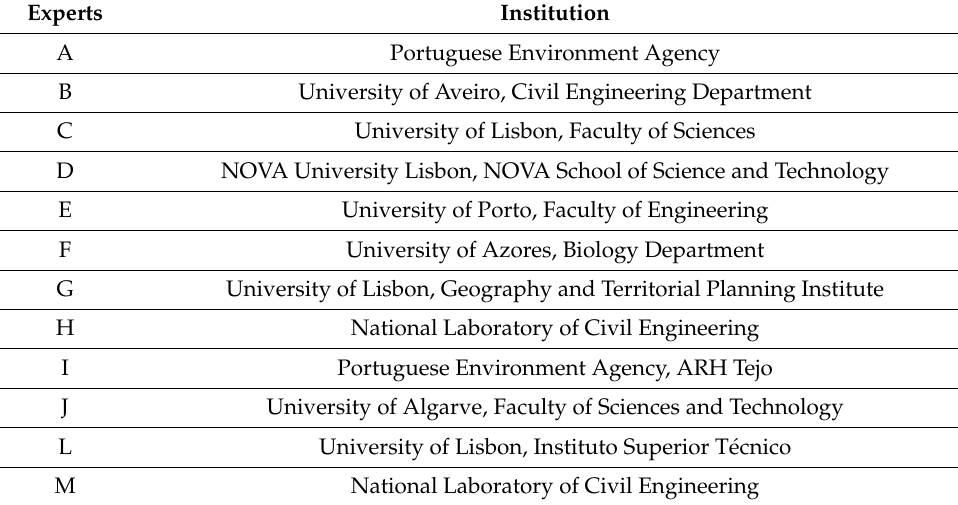
Table 16. Experts on coastal overtopping risk consulted for the weighting of the hazard and vulnera- bility criteria and sub-criteria.